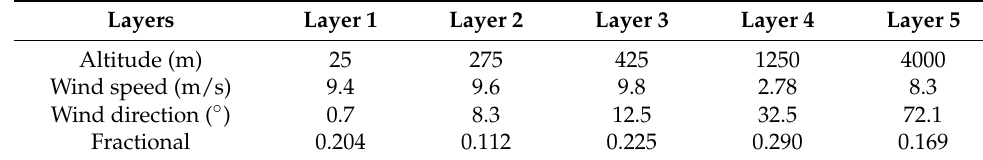
Table 2. Simulation parameters and their standard nominal values for r 0 of 10 cm.